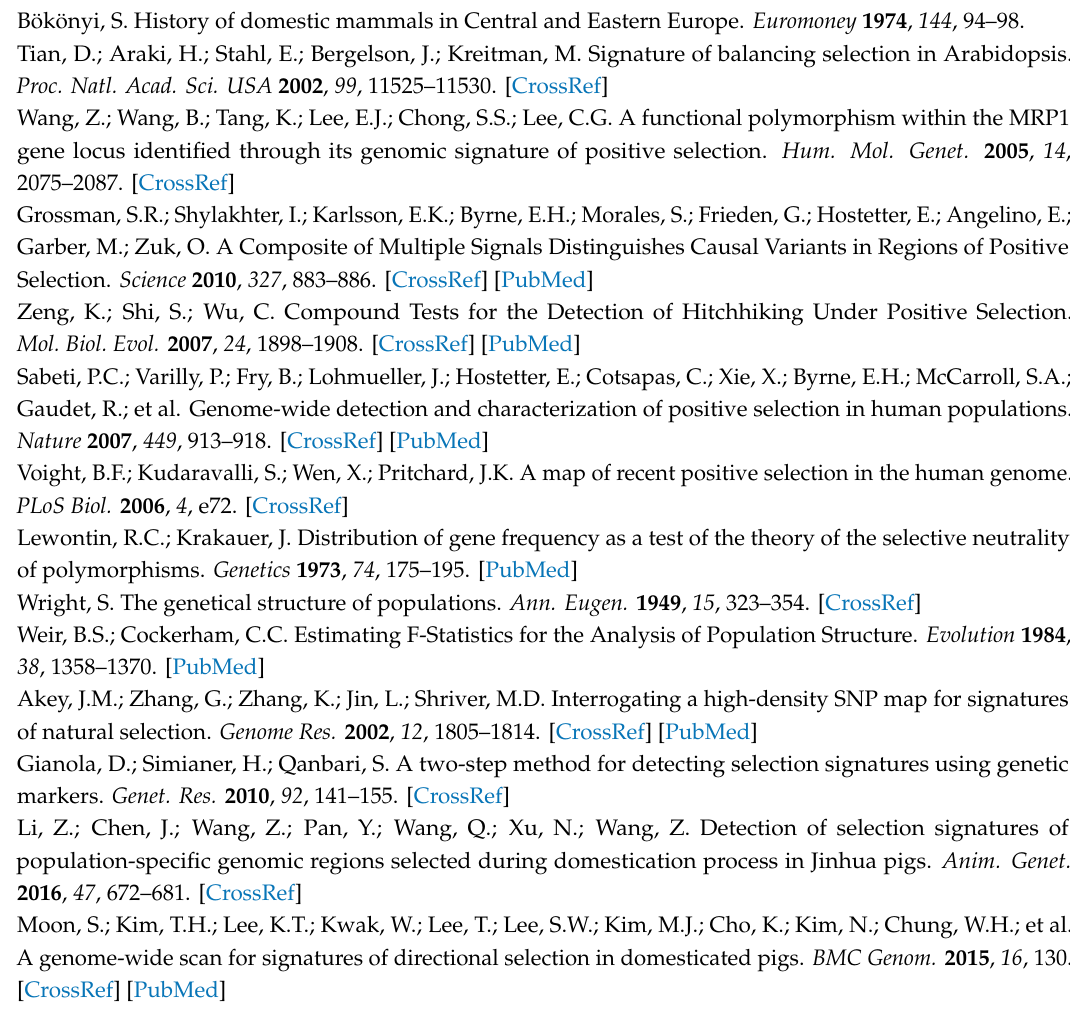
Figure S1: LD plot of significant SNPs in Hainan pigs and Baoshan pigs, Figure S2: LD plot of significant SNPs in Hainan pigs and Saba pigs, Table S1: Genetic distance within populations, Table S2: Significant SNPs detected by single method in Hainan pigs and Baoshan pigs, Table S3: Significant SNPs detected by single method in Hainan pigs and Saba pigs, Table S4: Summary of potential selection regions in Hainan pigs (Ding’an and Tunchang / Baoshan group), Table S5: Summary of potential selection regions in Baoshan pigs (Ding’an and Tunchang / Baoshan group); Table S6: Summary of potential selection regions in Hainan pigs (Ding’an and Tunchang / Saba group), Table S7: Summary of potential selection regions in Saba pigs (Ding’an and Tunchang / Saba